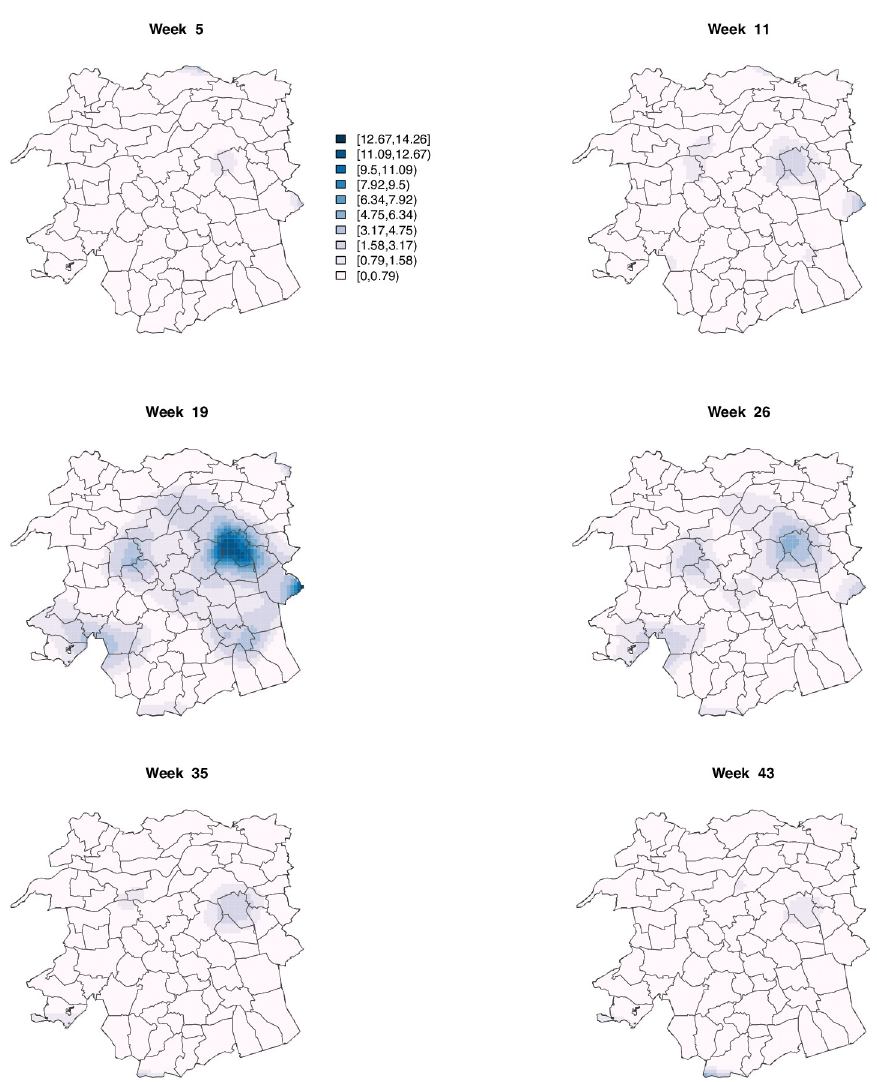
Fig 5. Approximate standard error maps associated with the smoothed Q fever incidence maps in Fig